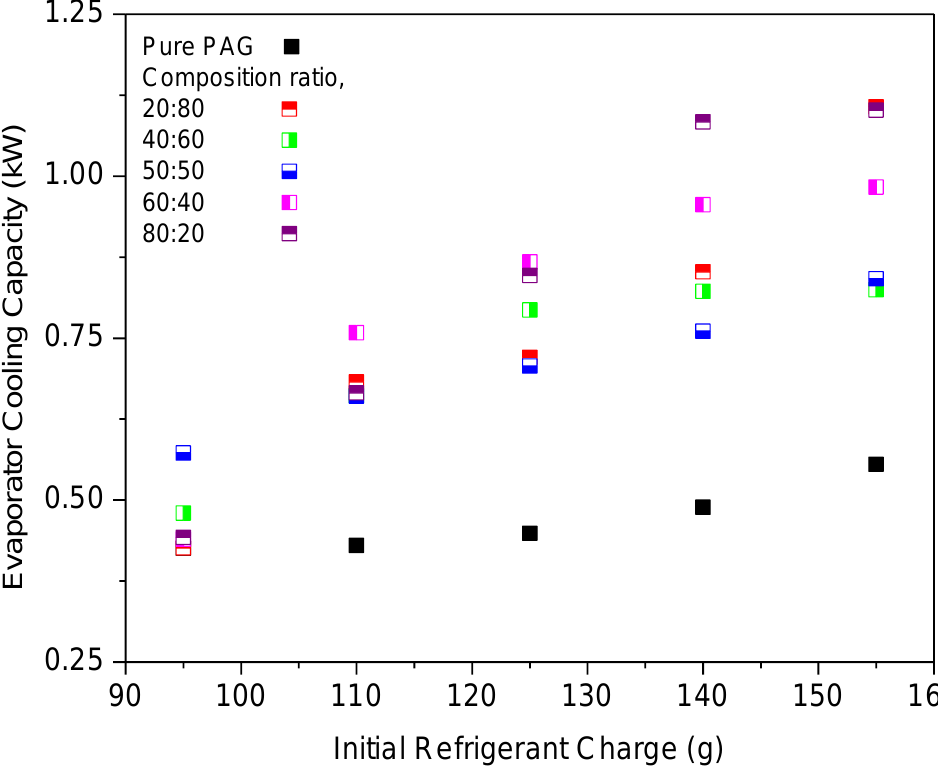
Figure 9. Cooling capacity of hybrid nanolubricants at various composition ratios.